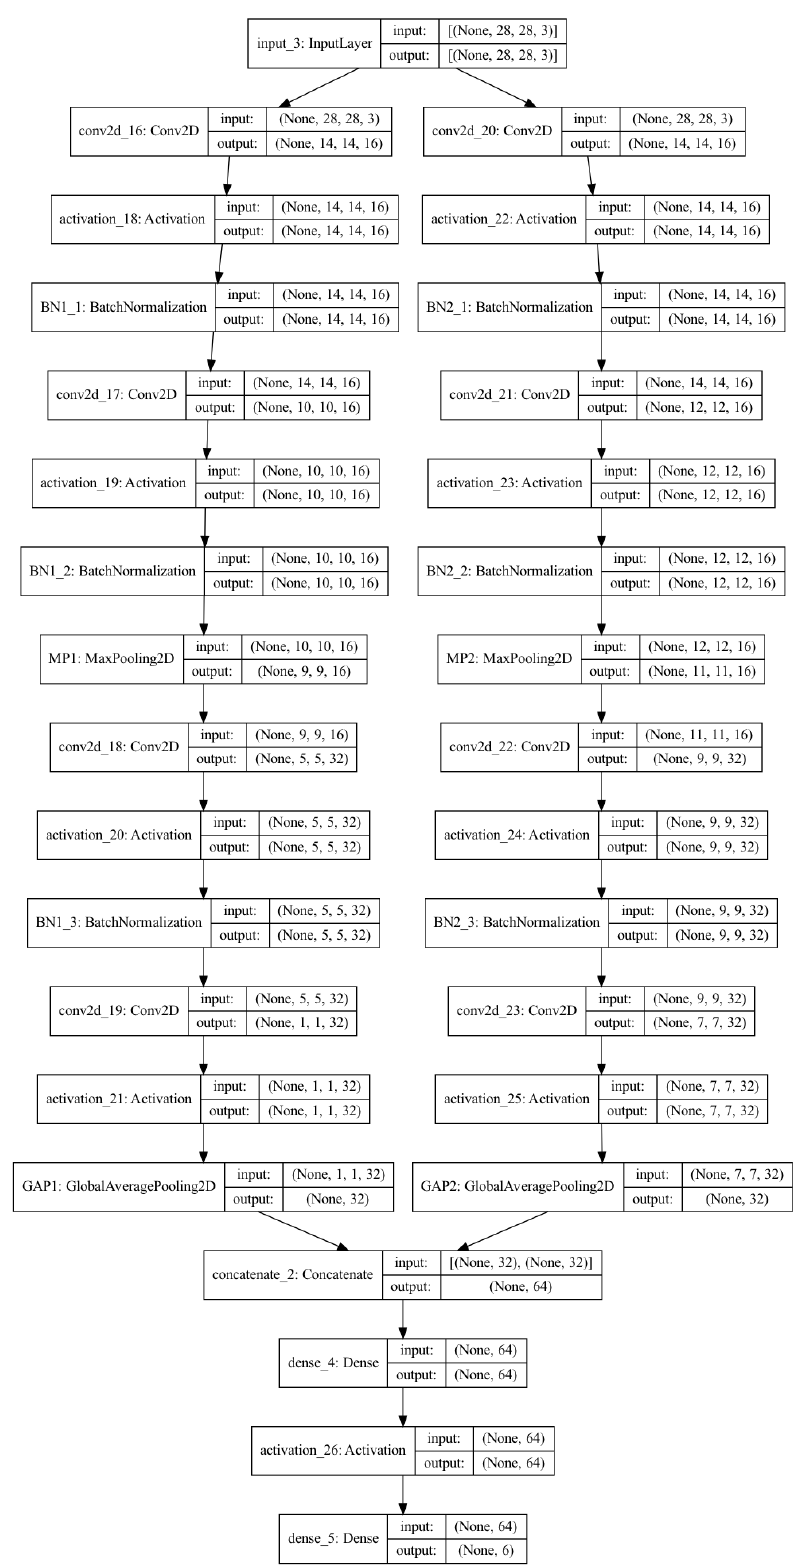
Figure 2. Proposed lightweight deep learning architecture 3 × 3_5 × 5-based convolution without batch normalization before the